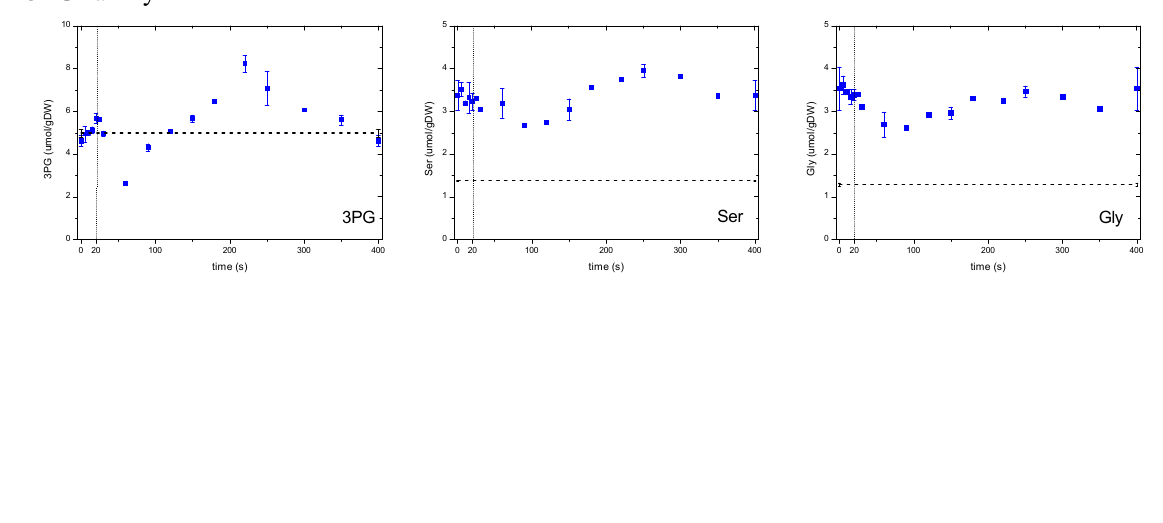
Figure A1. Concentration measurements of amino acids during the feast/famine cycle. The dashed line represents the reference steady-state (D=0.1 h -1 ), error bars represent the standard error of duplicate determination during two subsequent cycles. The vertical dotted line represents the end of the feeding